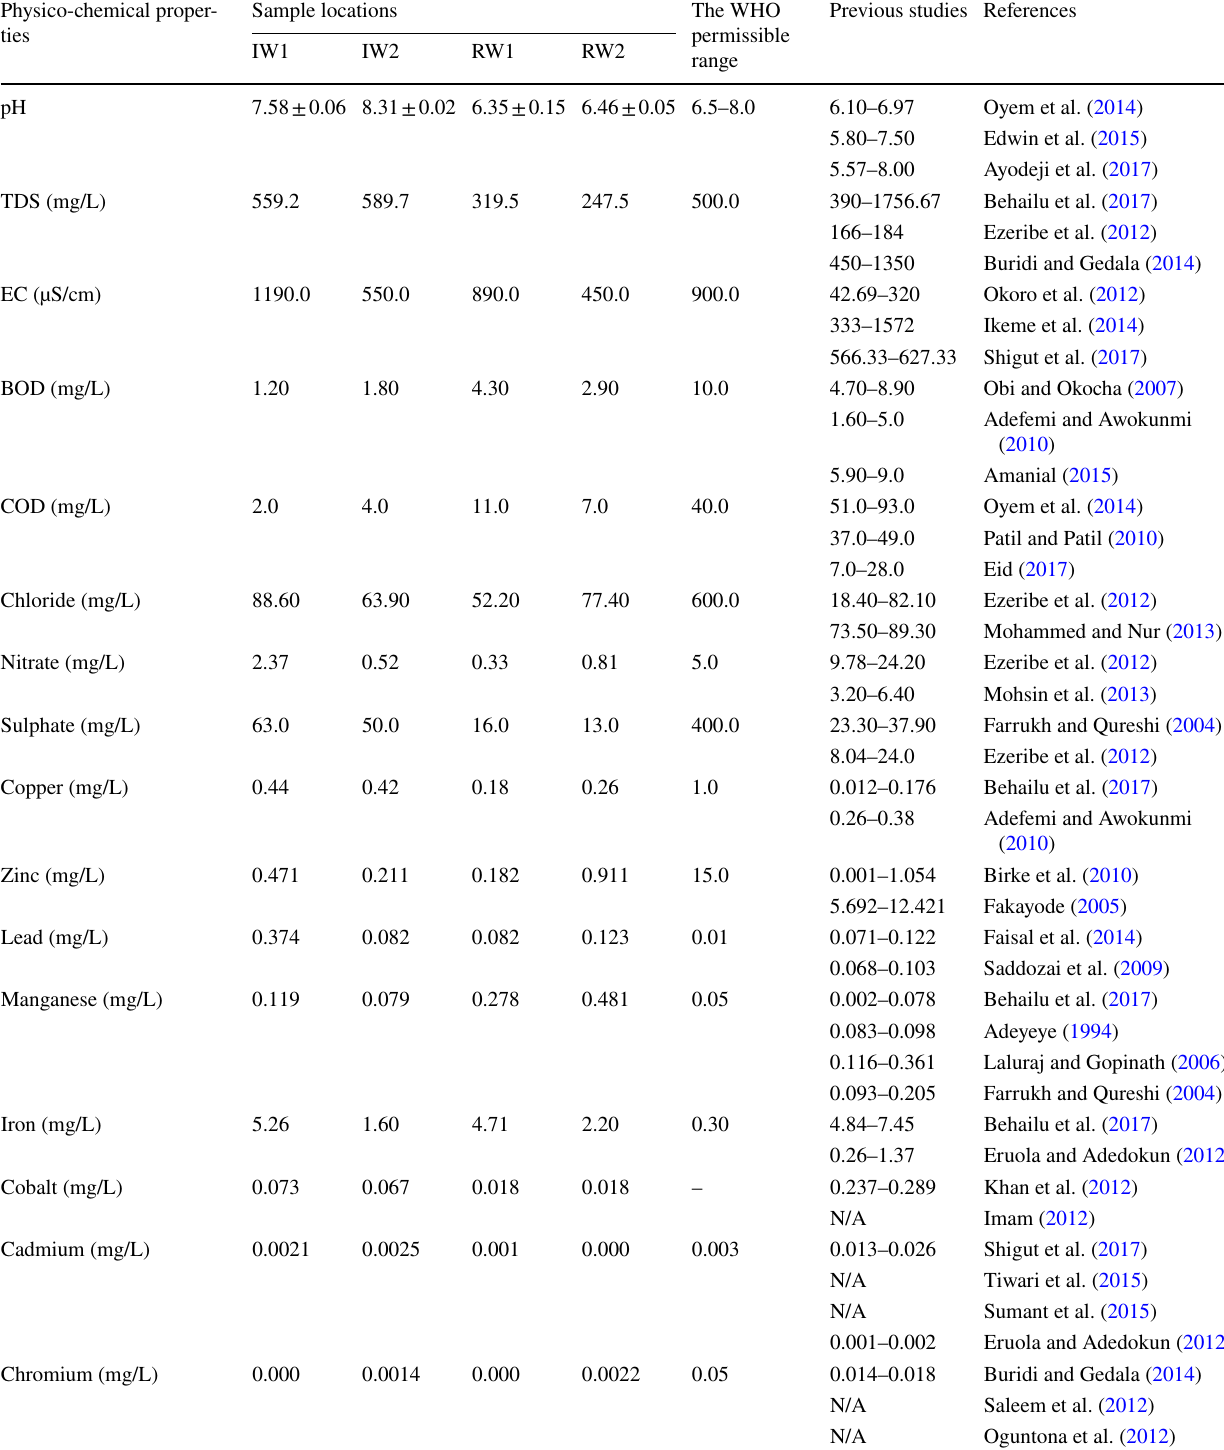
Table 1 Data of physico-chemical properties of groundwater examined in sample locations and previous studies Physico-chemical proper-